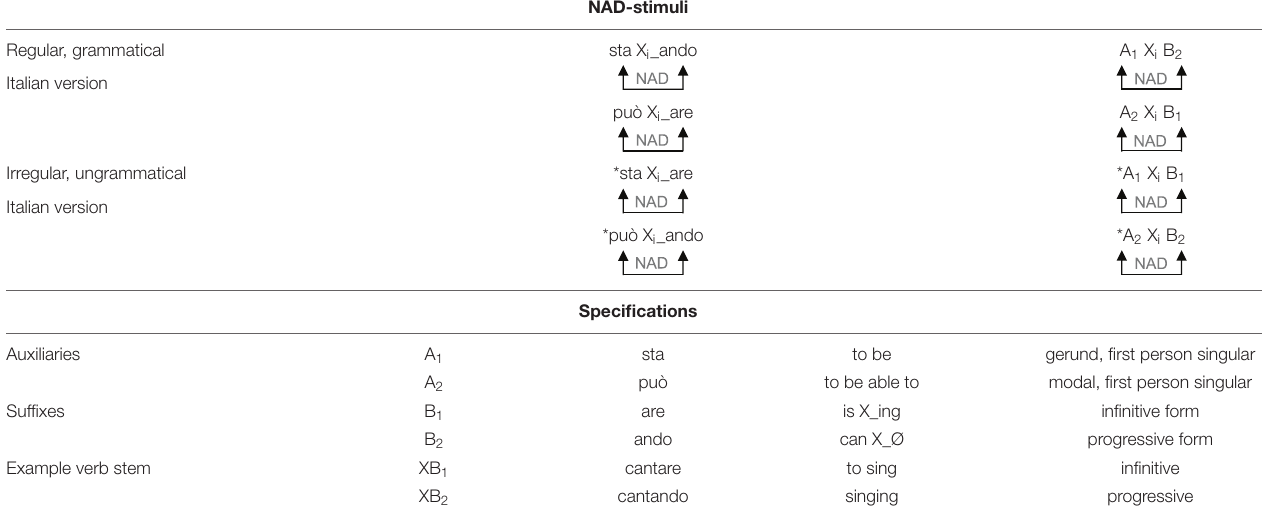
TABLE 2 | Stimuli and stimulus